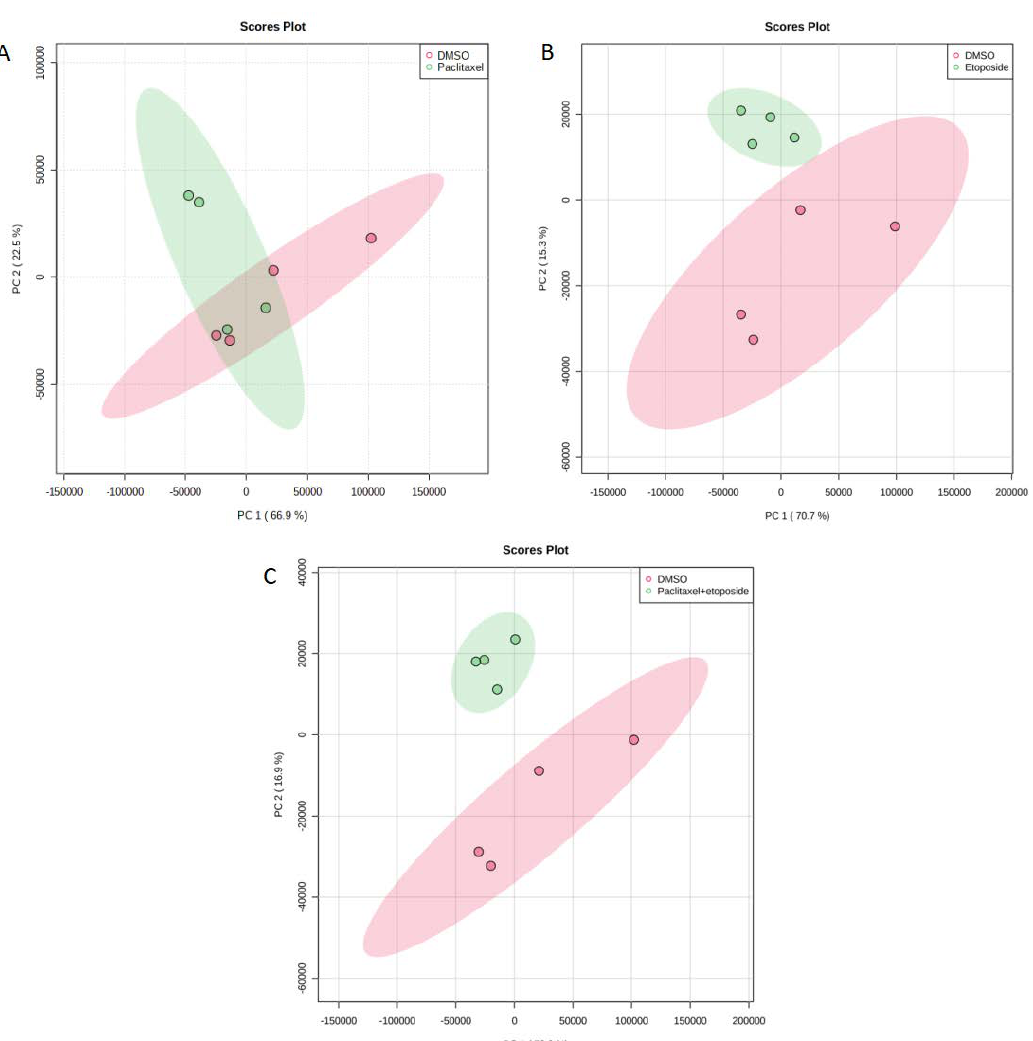
Figure 5. ( A ) PCA for DMSO with paclitaxel 4.2 nM; ( B ) PCA for DMSO with etoposide 10 µg/mL; ( C ) PCA for DMSO with (paclitaxel 4.2 nM + etoposide 10 µg/mL) in U373 cell line.